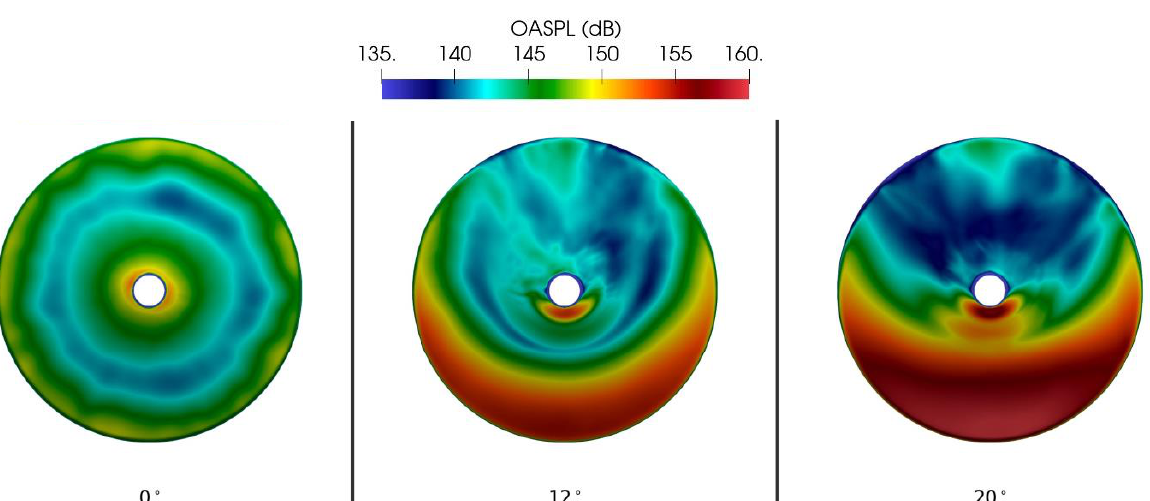
Figure 12. Turbulent kinetic energy spectrum at y/R = 1.